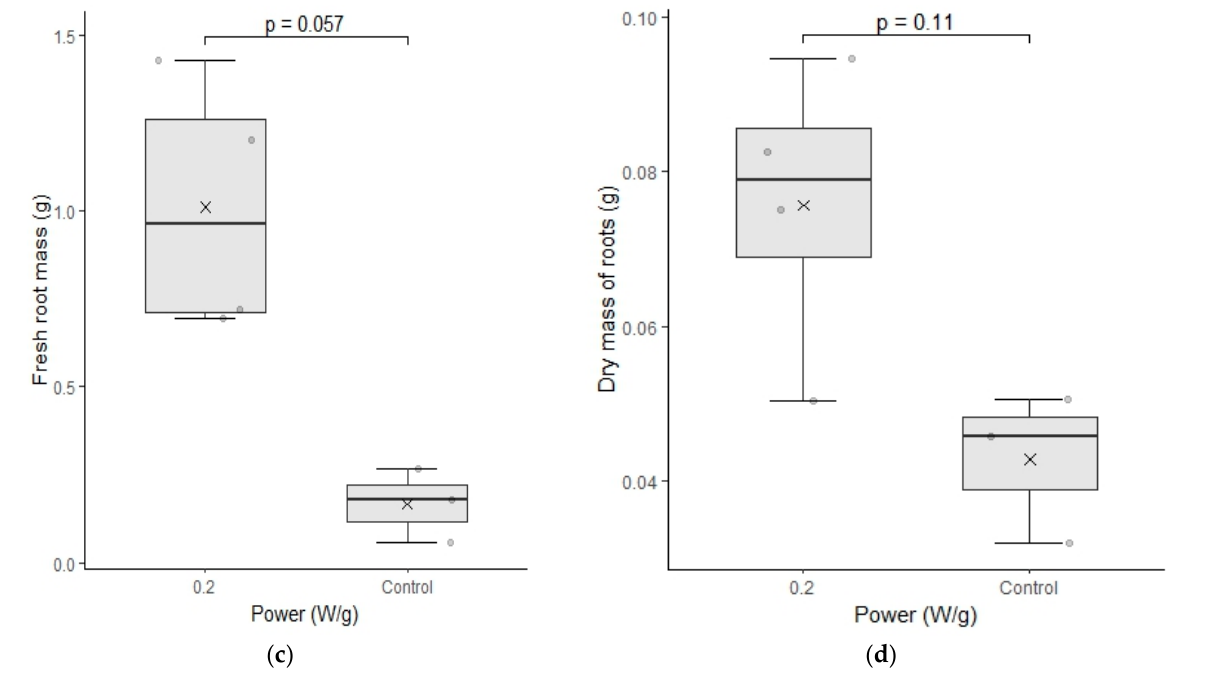
Figure 8. ( a – d ) represent the test of fresh mass and dry mass of cultivar C02. The differences were analyzed using the Mann–Whitney U test at a significance level of 0.05. The media, data, and p value are represented in the figures for the x, dots, and letter p , respectively.